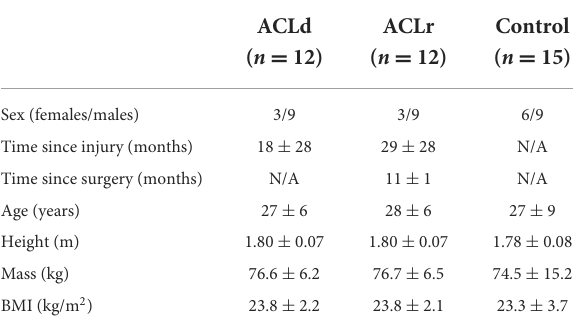
TABLE 1 Participant